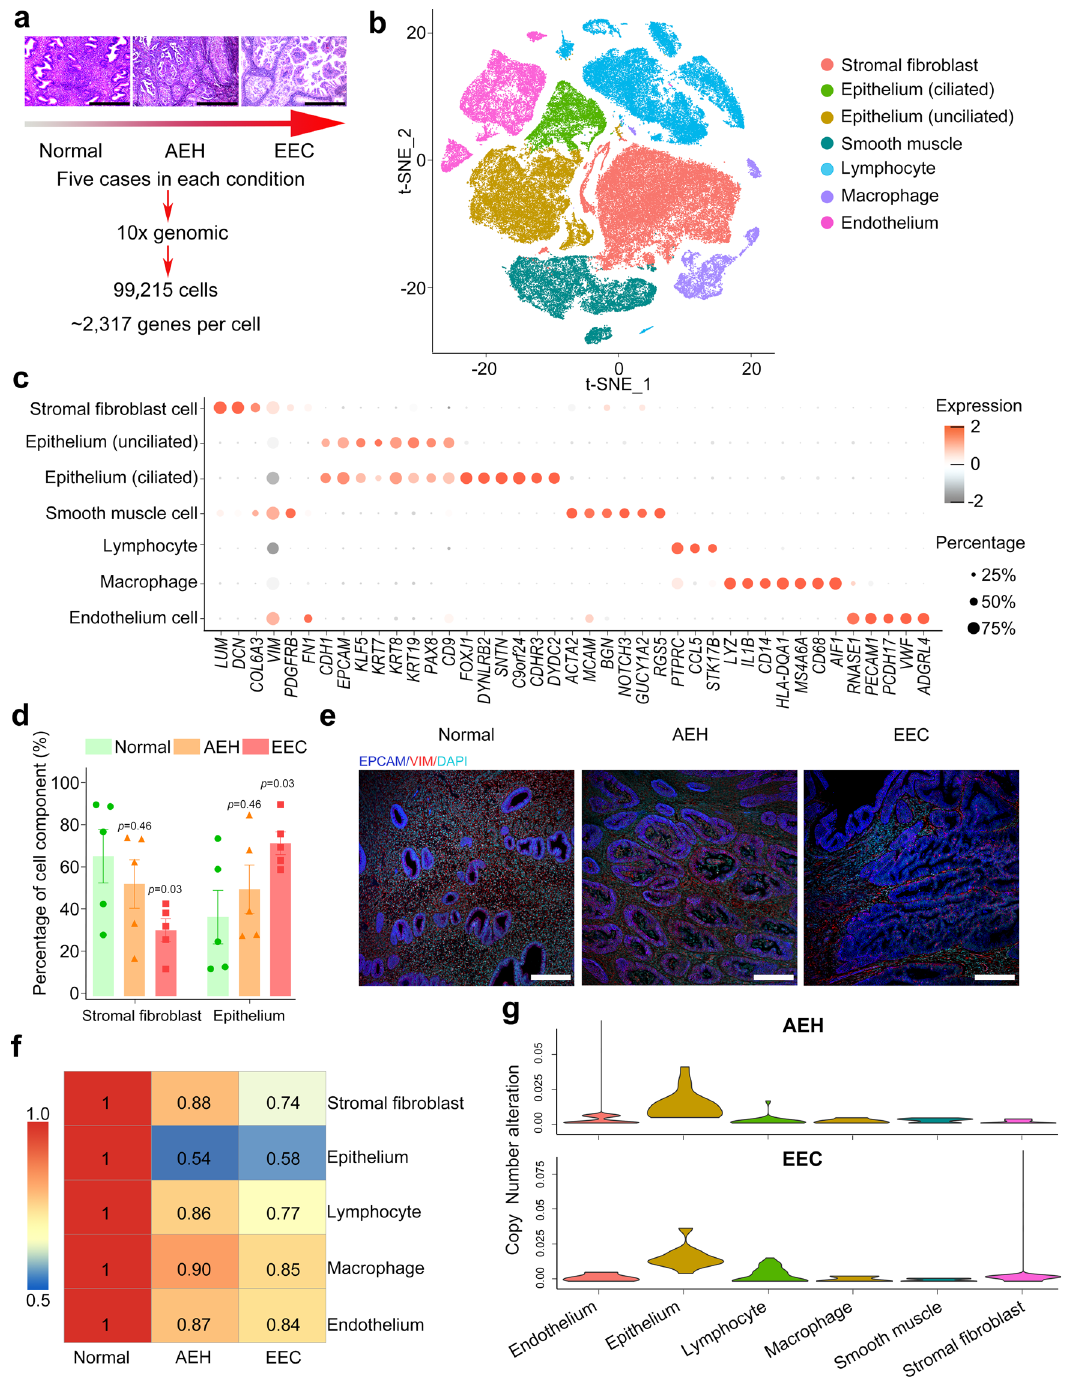
Fig. 1 | Cell population landscapes of endometrial pathology. a Overview of subjectsenrolled inthisstudyand representativeH&Estainingimageswereshown ( n =5 for each group, scale bar=500 μ m). Normal: normal endometrium; AEH: atypical endometrial hyperplasia; EEC: endometrioid endometrial cancer. b t-SNE plot showed six main cell type clusters of 15 specimens from different stages of endometrial pathology. c Expression patterns of canonical markers and differen- tiallyexpressedgenes(DEGs)ofeachcelltype.Eachdotrepresentsagene,ofwhich the color saturation indicates the average expression level, and the size indicates thepercentageofcellsexpressingthegene. d Thepercentageofstromal fi broblast and epithelial cells at different stages of endometrial pathology (Source data are